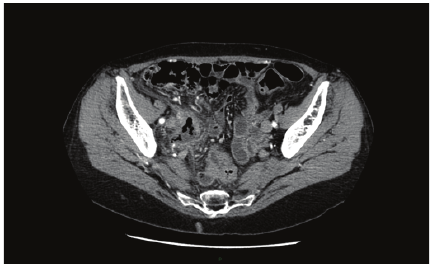
Figure 2: Pelvic mass involving right